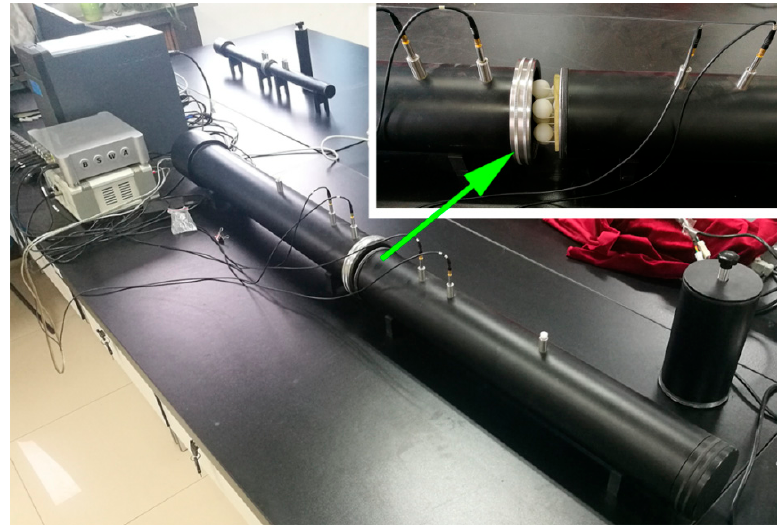
Figure 3. Physical diagram of the impendence tube testing equipment.